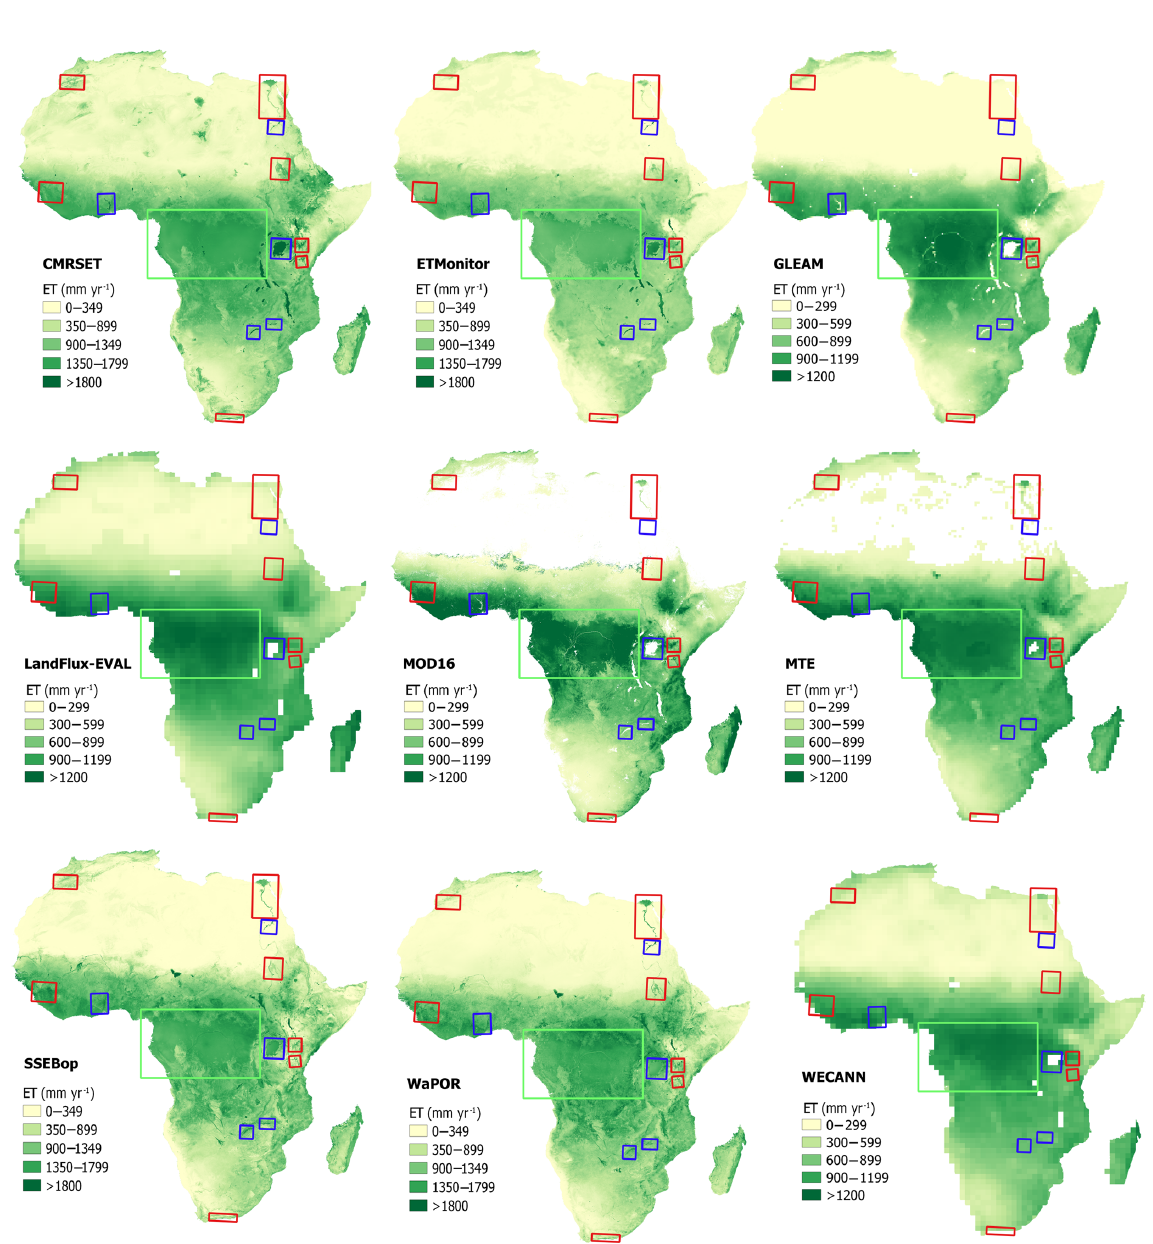
Figure 10. Spatial assessment of each ET product based on selected land cover elements, forest, irrigated areas and water bodies across Africa. Red boxes indicate irrigated areas, blue boxes indicate water bodies and green boxes indicate forested